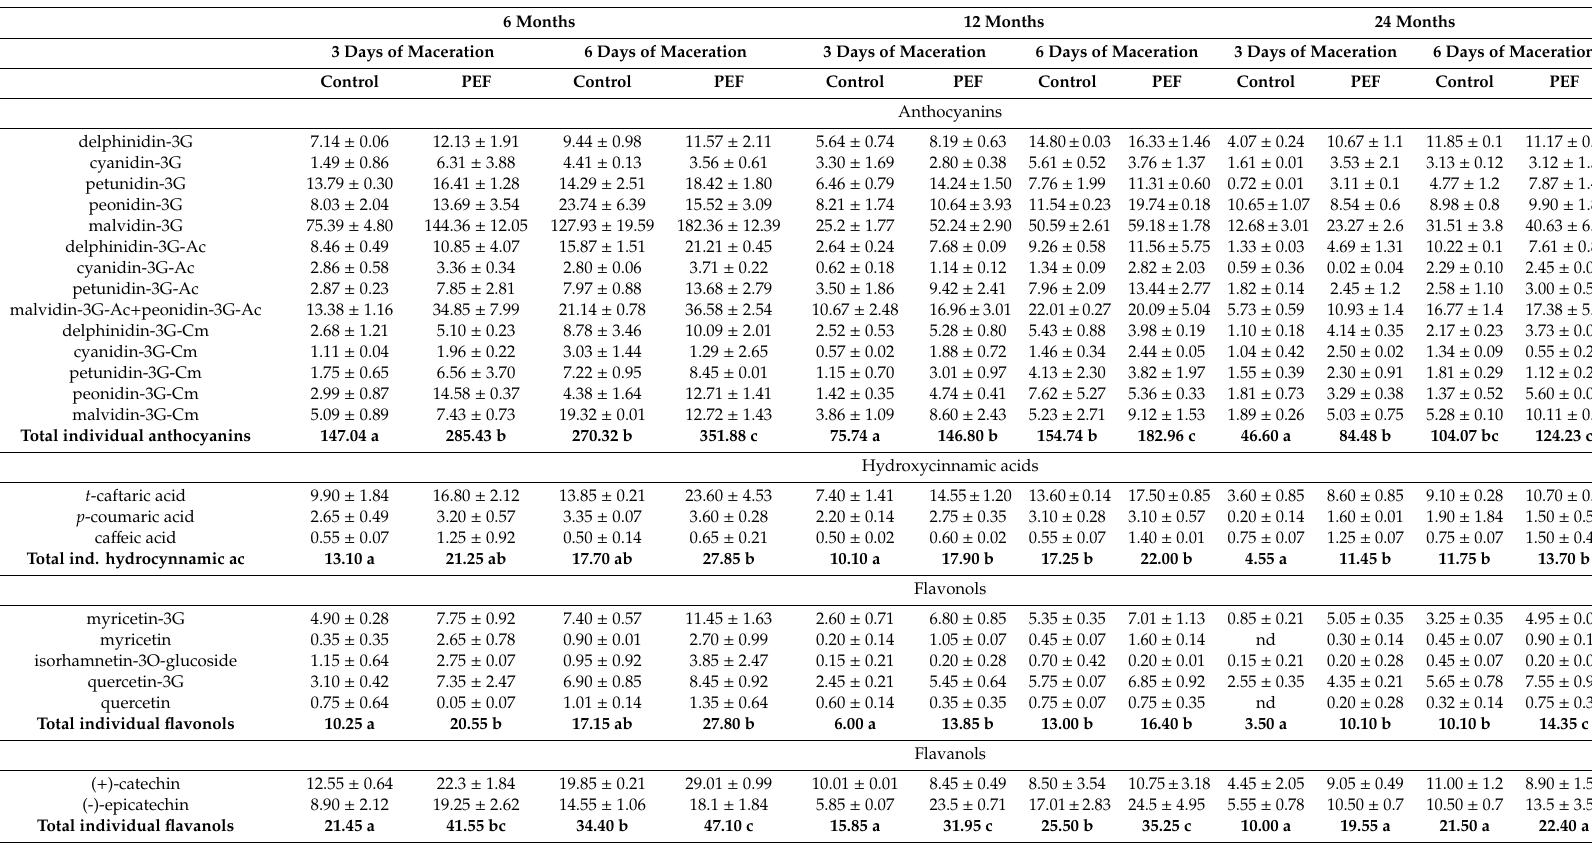
Table 3. Evolution of individual phenolic compounds (mg L − 1 ) in wines obtained from untreated and PEF-treated grapes with 3 and 6 days of maceration after 6 months of aging in oak barrels plus 18 months bottle aging.